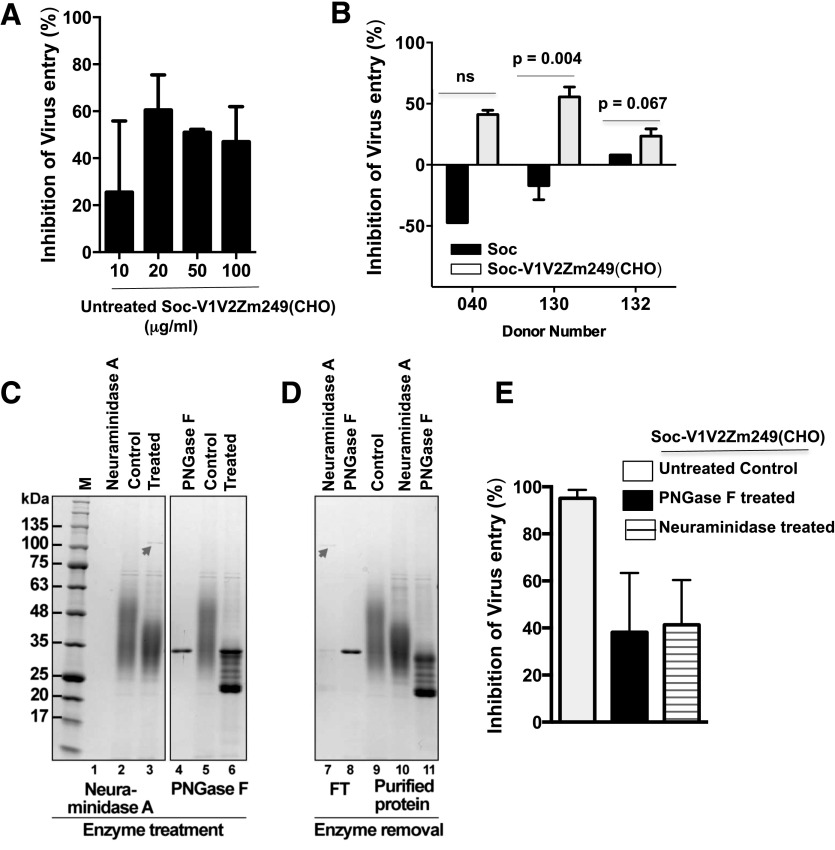
Soc–V1V2 protein inhibits HIV-1 entry.M-CSF–derived MDMs were preincubated with Soc-V1V2Zm249 (CHO) (A) or Soc-CHO or Soc-V1V2Zm249 (CHO) (B) and infected with HIV-1. Lysates were analyzed for HIV-1 gag RNA. (C) CHO expressed Soc-V1V2 Zm249 protein (untreated, lanes 2, 5), after treatment with (neuraminidase A, lane 3), (PNGase F, lane 6), and enzymes alone (lanes 1, 4). (D) Neuraminidase A and PNGase F are shown in the flow-through fractions (lanes 7 and 8). Bound Soc-V1V2 proteins eluted with imidazole (untreated, lane 9; neuraminidase A treated, lane 10; PNGase F treated, lane 11). Arrows show the neuraminidase A band. (E) M-CSF–derived MDMs were preincubated with untreated Soc-V1V2Zm249 (CHO) (open bars), PNGase F-treated (filled bars), or neuraminidase A-treated Soc-V1V2Zm249 (CHO) (hatched bars), infected with HIV-1 and were analyzed for the presence of intracellular p24. Bar graphs show the percentage inhibition of infectivity (means ± sd). (*P = 0.03 compared with the untreated Soc-V1V2Zm249 (CHO) protein, Mann-Whitney test).